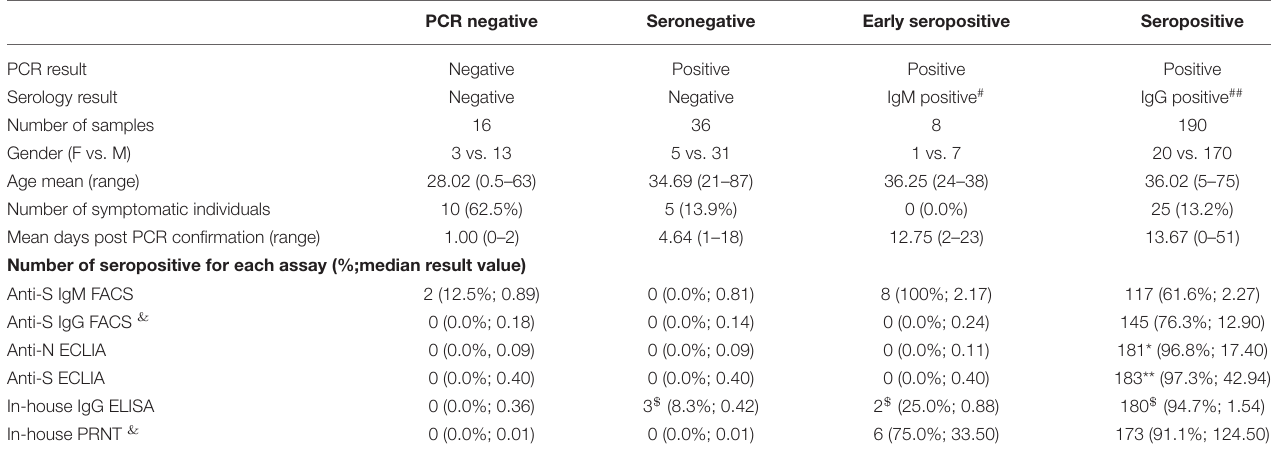
TABLE 2 | Study cohort characteristics and results of serological